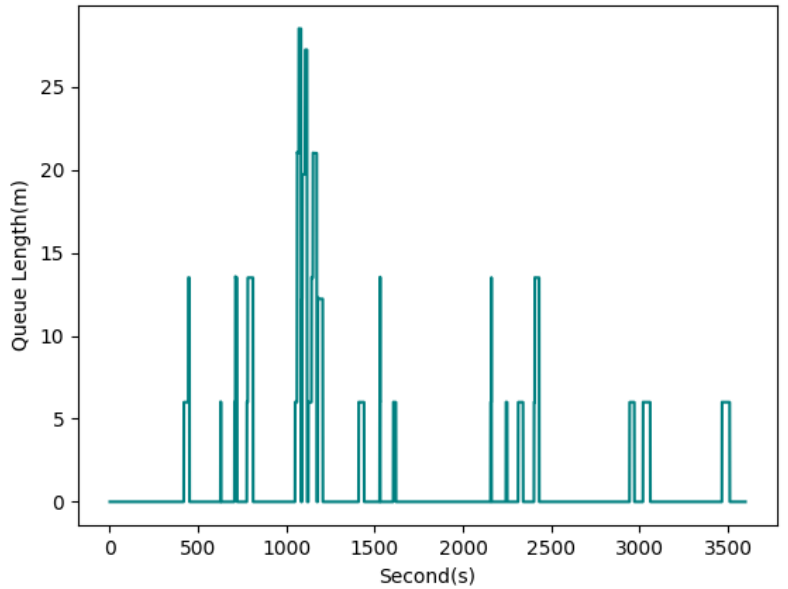
Figure 11. Queue length estimation for edge 1i of INT2 (AVG: 1.32 m, STD: 4.14 m).